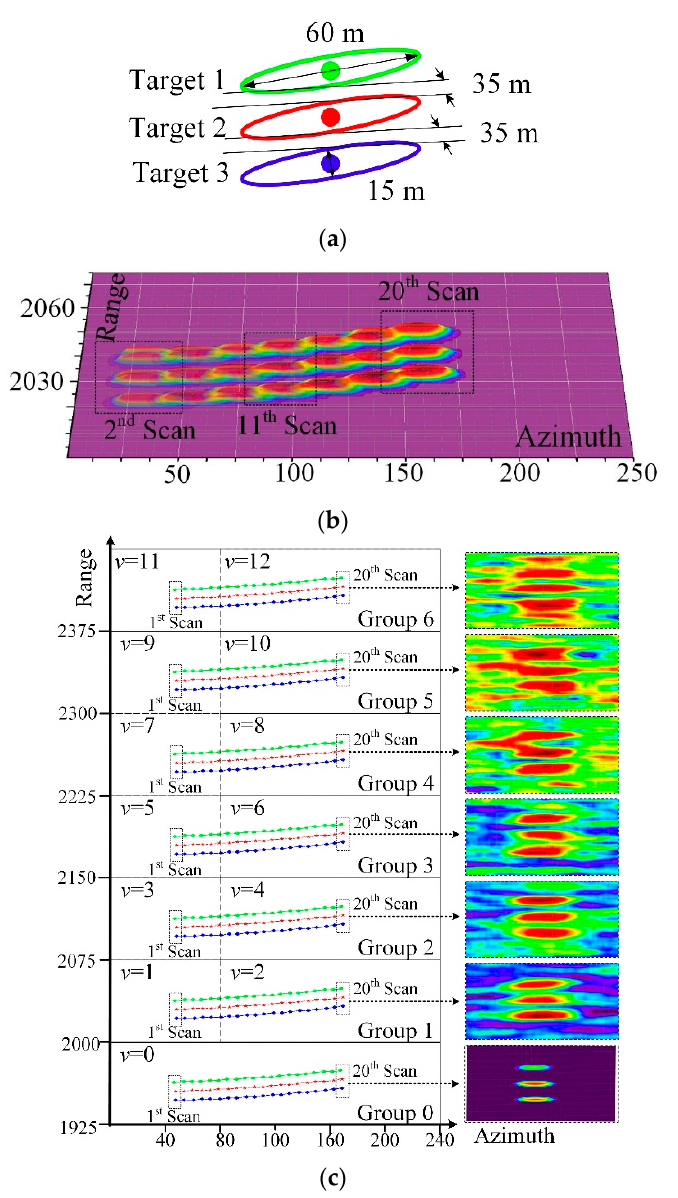
Figure 8. The synthetic data in this work: ( a ) the configuration of the fleet; ( b ) the echoes of the three targets among 20 scans; and ( c ) the synthetic scenario.